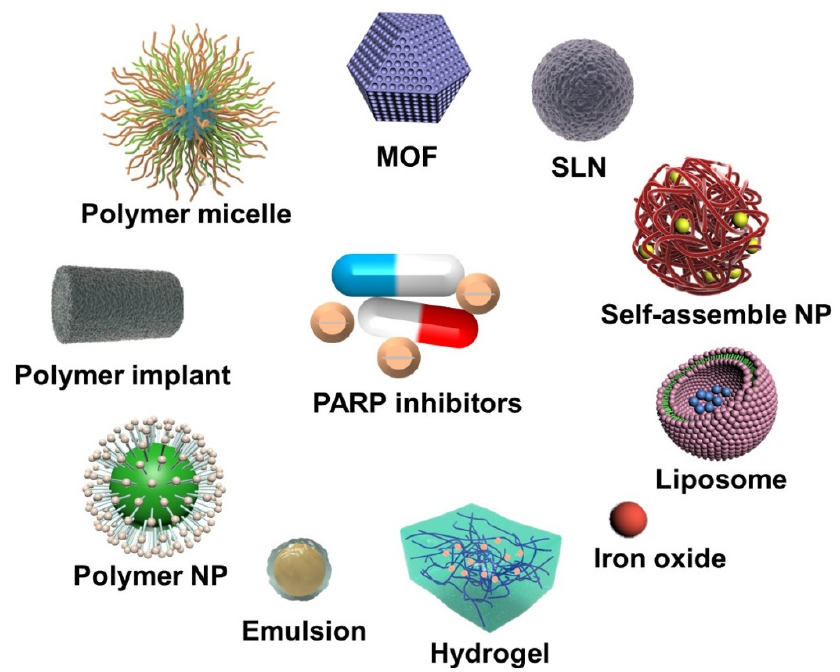
Figure 1. Different types of nanosystems for the delivery of PARP inhibitors in this review. (PARP: poly (adenosine diphosphate [ADP]–ribose) polymerases; MOF: metal-organic framework; SLN: solid lipid nanoparticle; NP: nanoparticle).